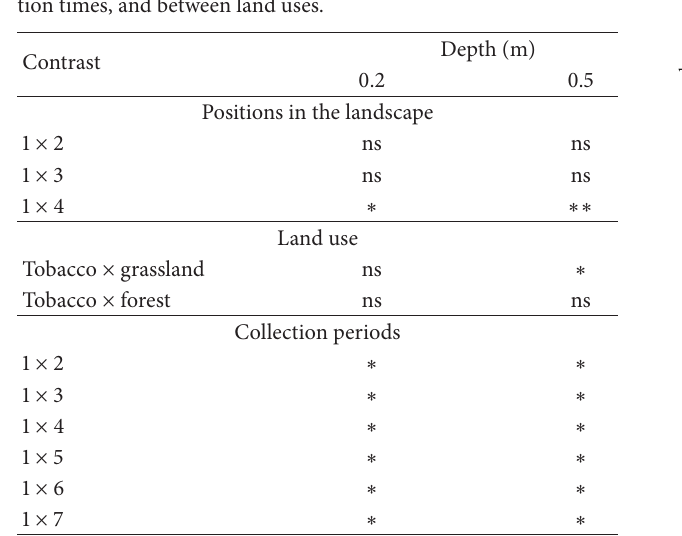
Figure 4: Nitrate concentration in water from the sources used for domestic